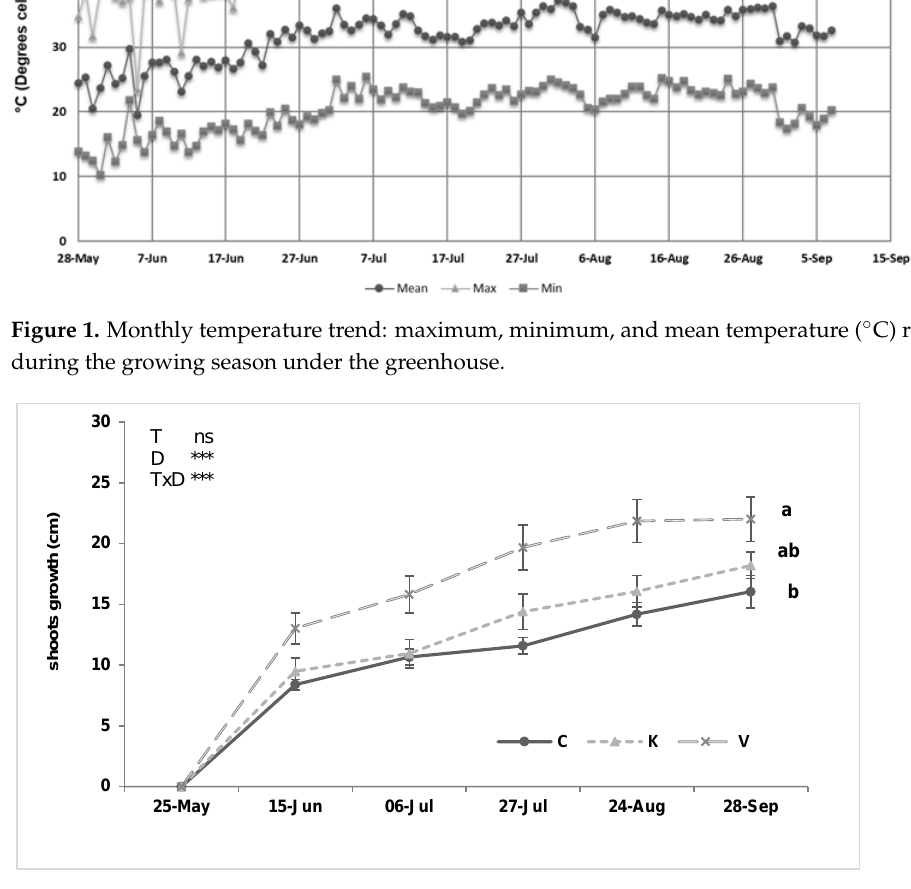
Figure 1. Monthly temperature trend: maximum, minimum, and mean temperature (°C) recorded during the growing season under the greenhouse.